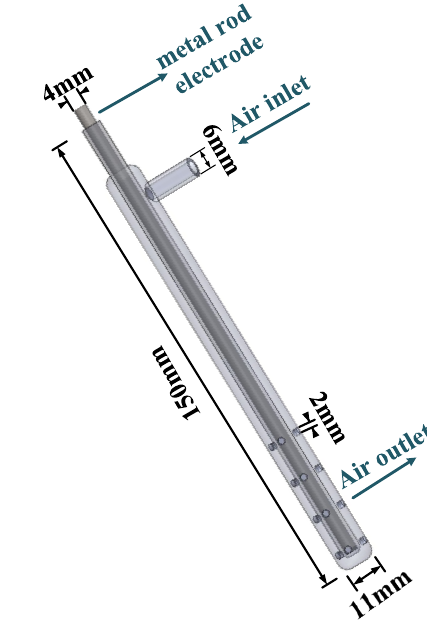
Figure 2. The schematic of the DBD tube.